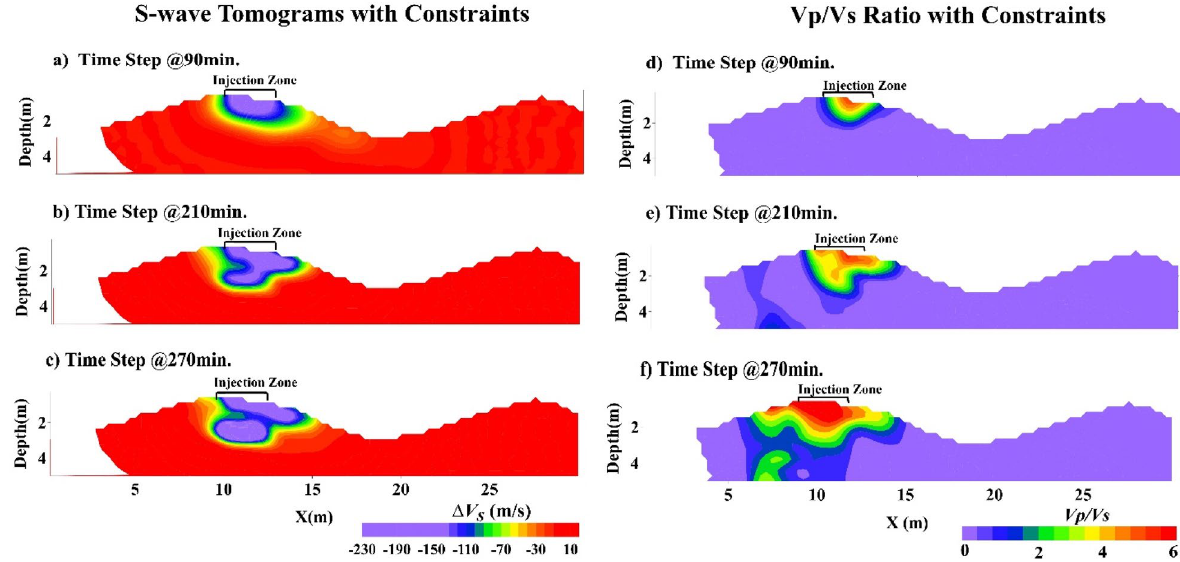
Figure 4. S-velocity tomograms in the left column have been computed using the gradient regularization constraint described in the text and the right column consists of the Vp/Vs ratio tomograms using the Vp and Vs tomograms in the left columns of Figs. 2 and 3, respectively. Surfer 11 (https:// www. golde nsoft ware. com/ produ cts/ surfer) is used to plot this Figure.